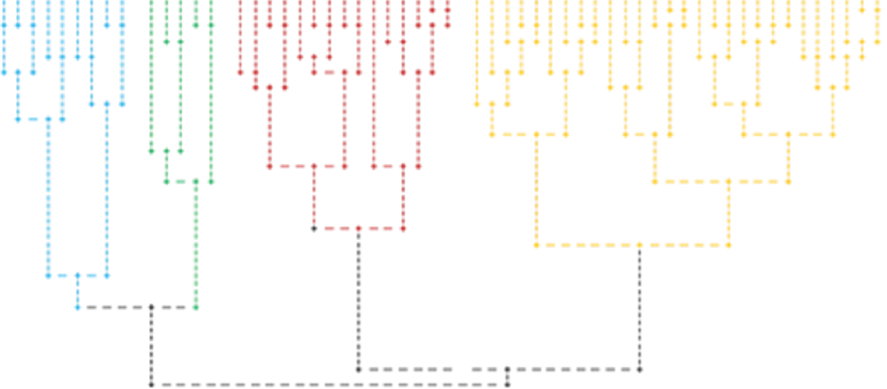
Figure 3. The dendrogram of hierarchical clustering using the complete linkage method and the